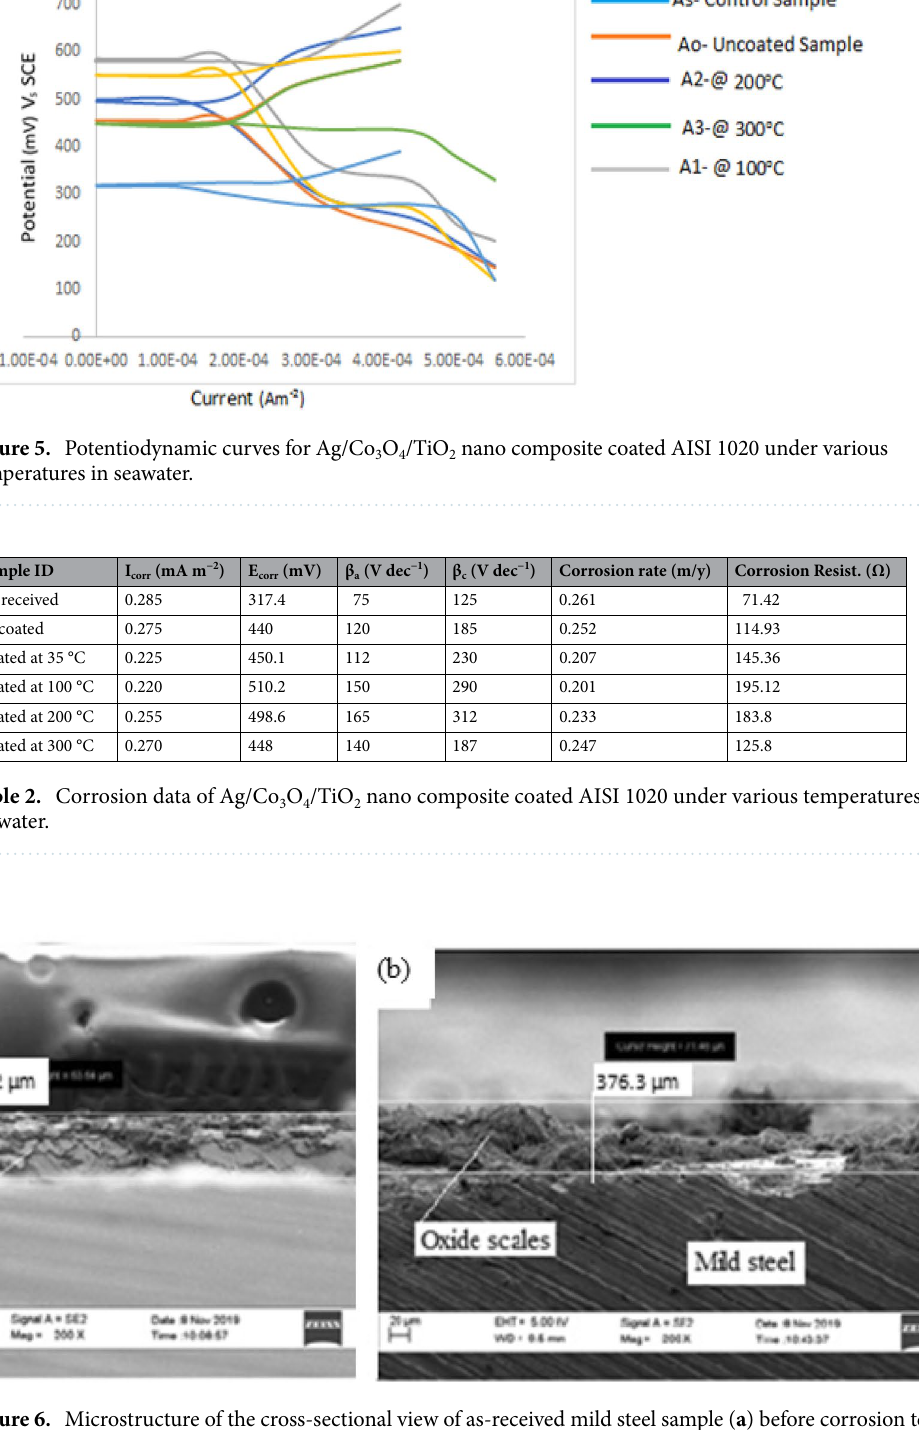
Figure 6. Microstructure of the cross-sectional view of as-received mild steel sample ( a ) before corrosion test ( b ) after